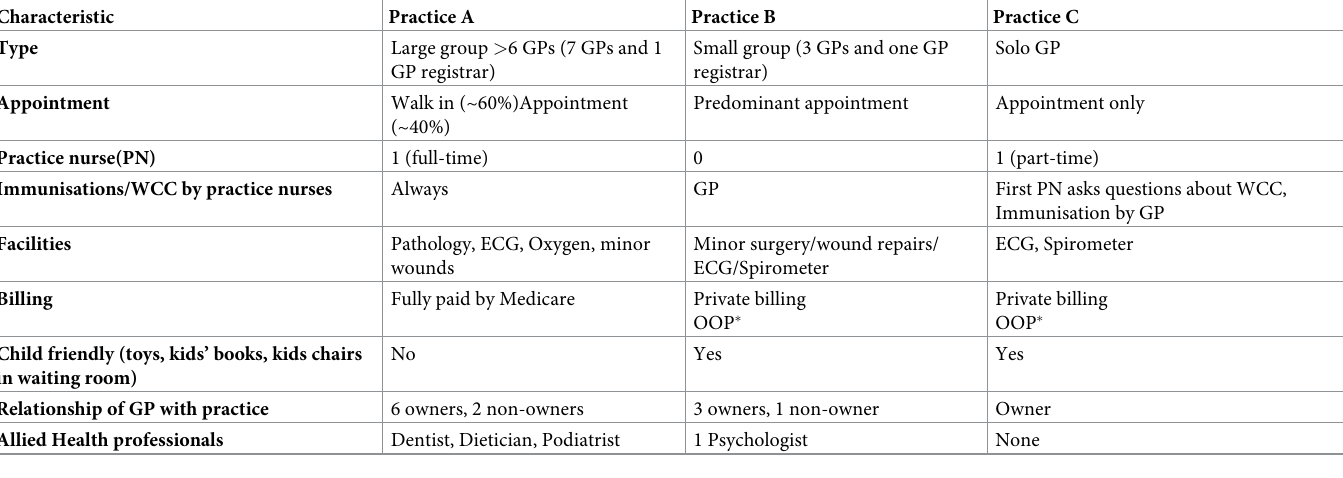
Table 1. Characteristics of recruited practices.